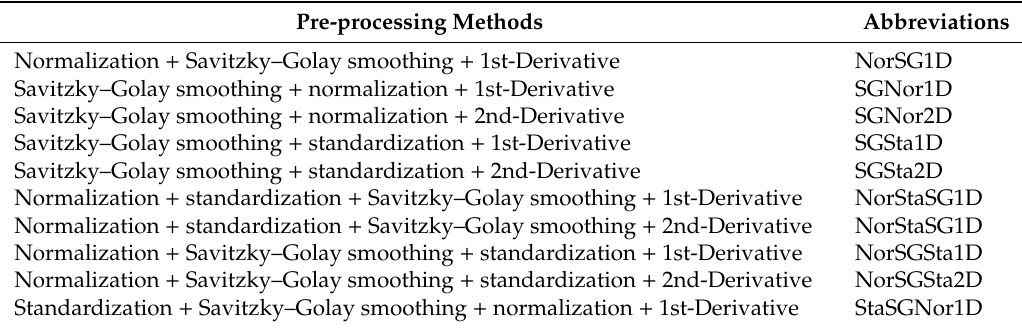
abbreviations. In the combined pre-processing methods, the order of abbreviations represented the priority of pre-processing methods. Take NorSG1D as an example. The abbreviation represented first normalization, then Savitzky–Golay smoothing followed by 1st-Derivative. Table 1. Pre-processing methods and their corresponding